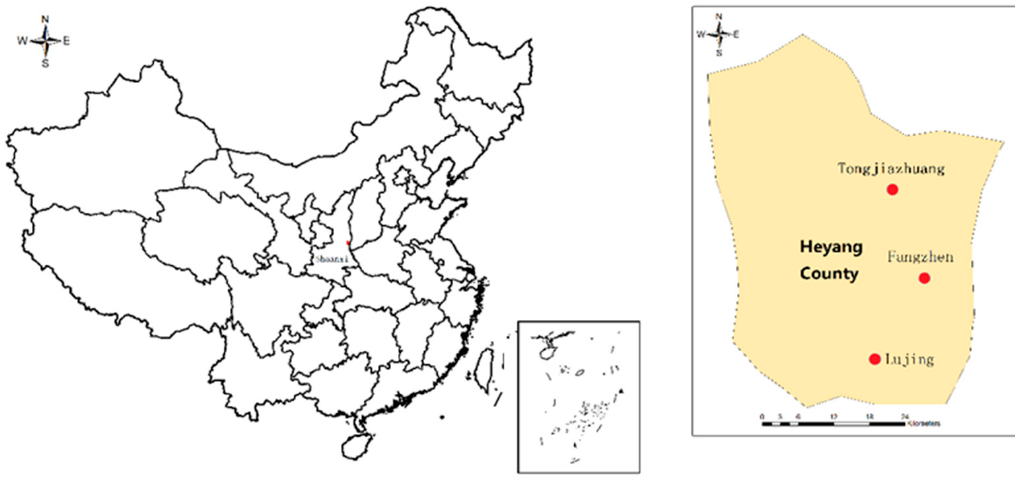
Figure 2. Regional distribution.